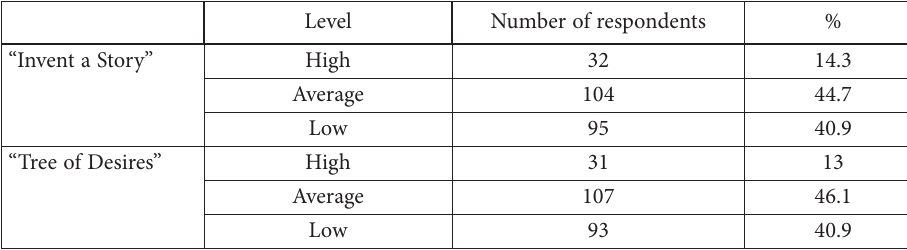
Table 2. Quantitative characteristics of empirical results of diagnostic